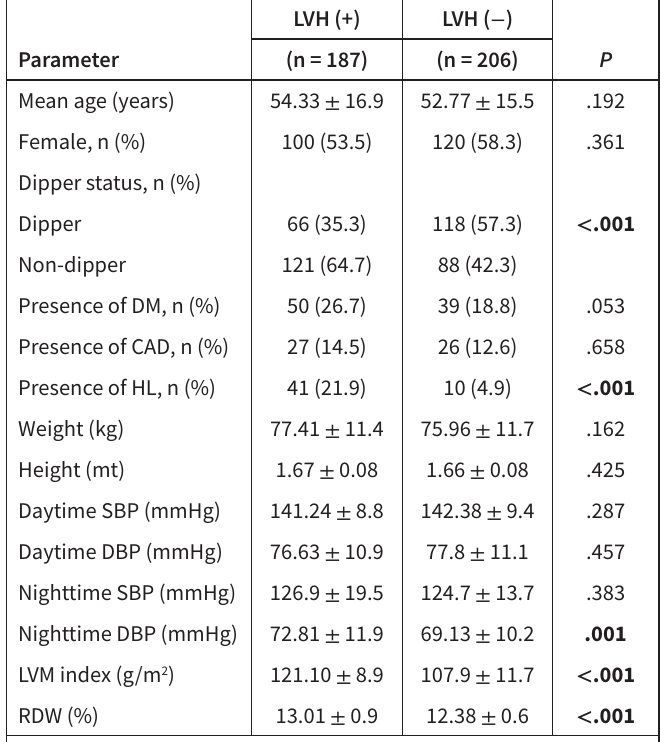
Table 1. Characteristic Features of Patients According to LVH Groups